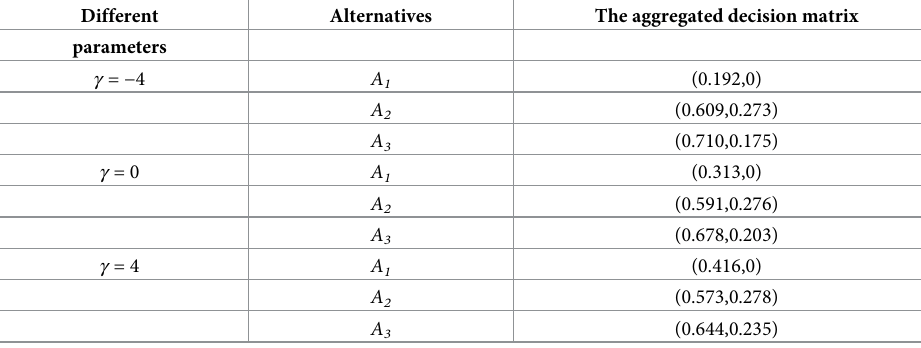
Table 11. Three individual weighted (on attributes and DMs) decision matrices.